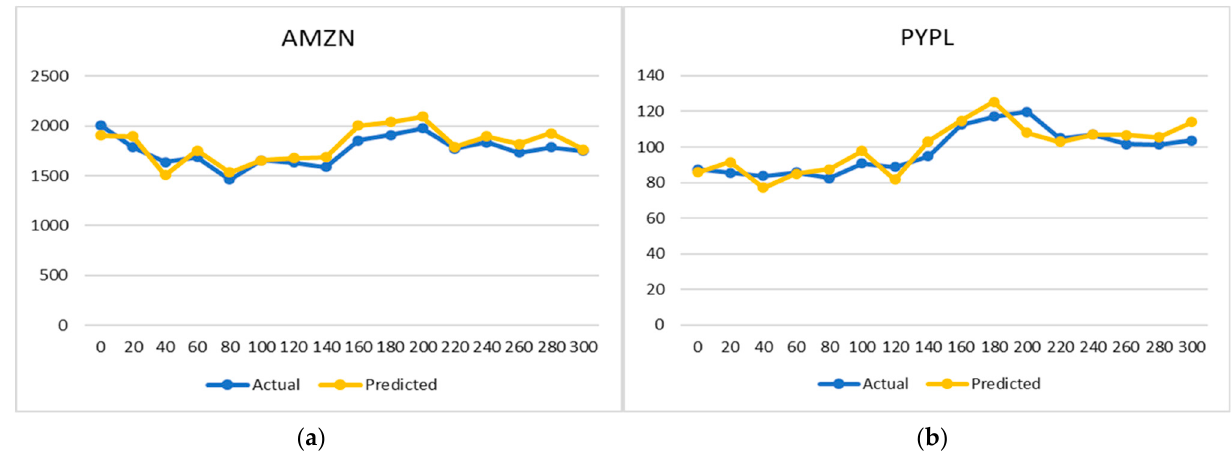
Figure 8. Stock trend prediction for ( a ) TSLA and ( b ) WMT.